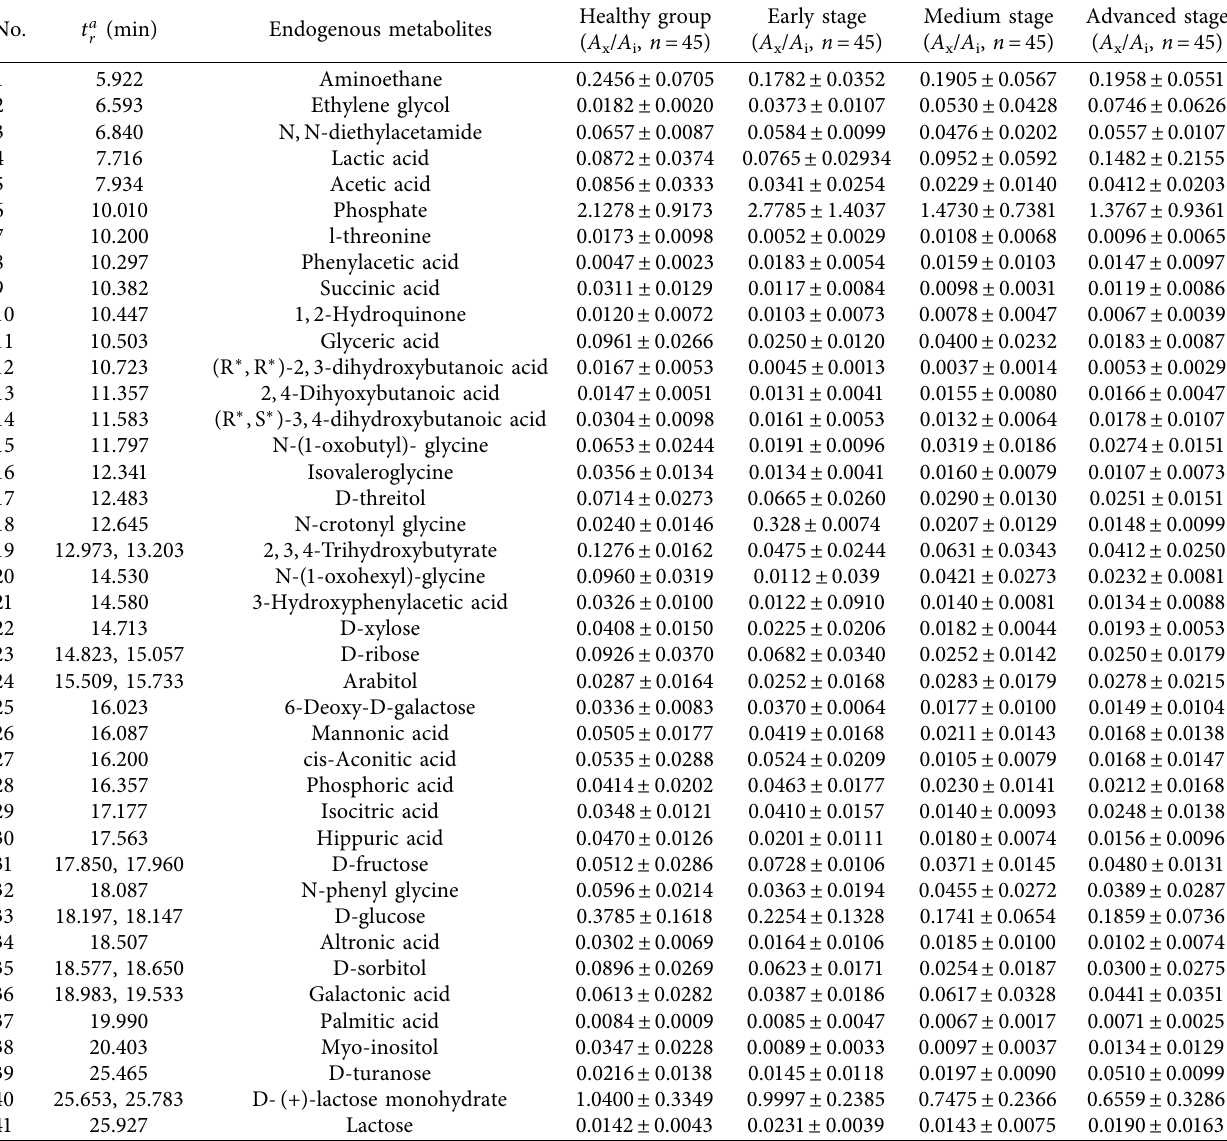
Table 1: Qualitative and quantitative results of 41 common chromatographic peaks in urine